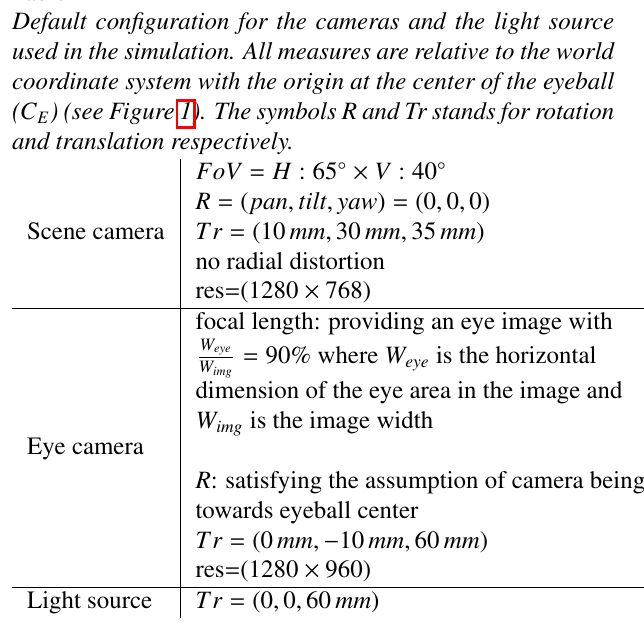
Default configuration for the cameras and the light source used in the simulation. All measures are relative to the world coordinate system with the origin at the center of the eyeball (C E ) (see Figure 1). The symbols R and Tr stands for rotation and translation respectively.